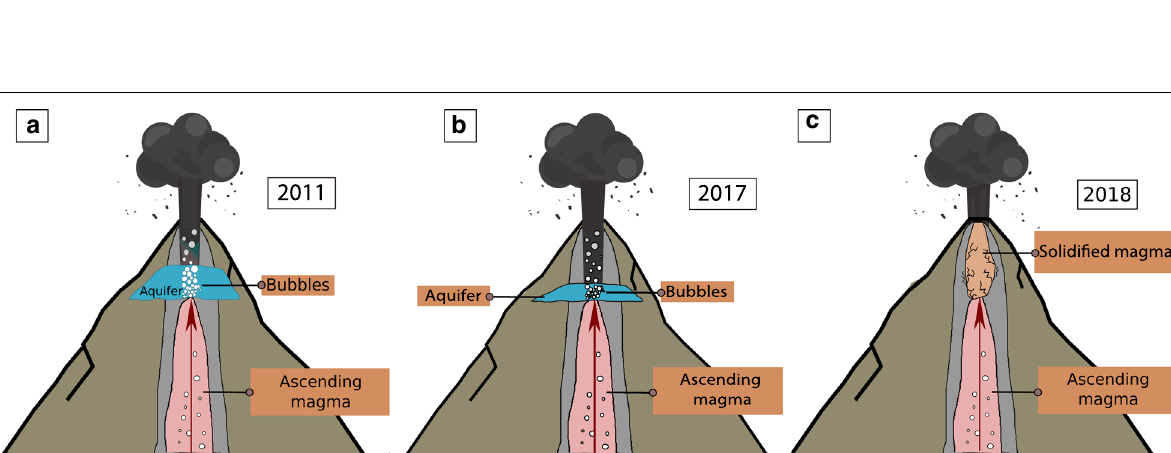
Fig. 7 Cartoon that summarizes the physical processes which took place in a 2011 when ascending magma interacts with the water of the aquifer, b 2017 when the aquifer has diminished in size, and c 2018 when the aquifer had evaporated and was replaced by solidified magma that was left over inside the conduit from previous eruptions (see text for